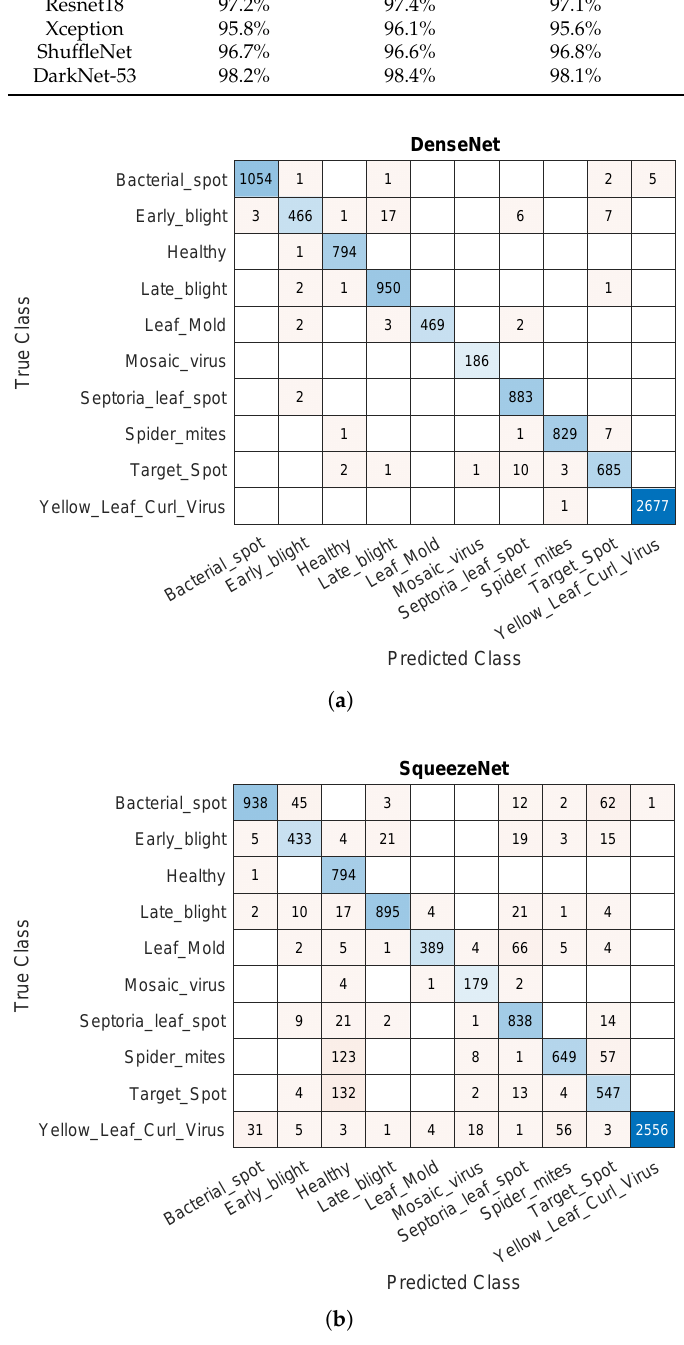
Figure 3. Sample confusion matrices for the best (DenseNet-201) and the worst (SqueezeNet) per- forming models using 50% of the data for training. ( a ) DenseNet-201; ( b )